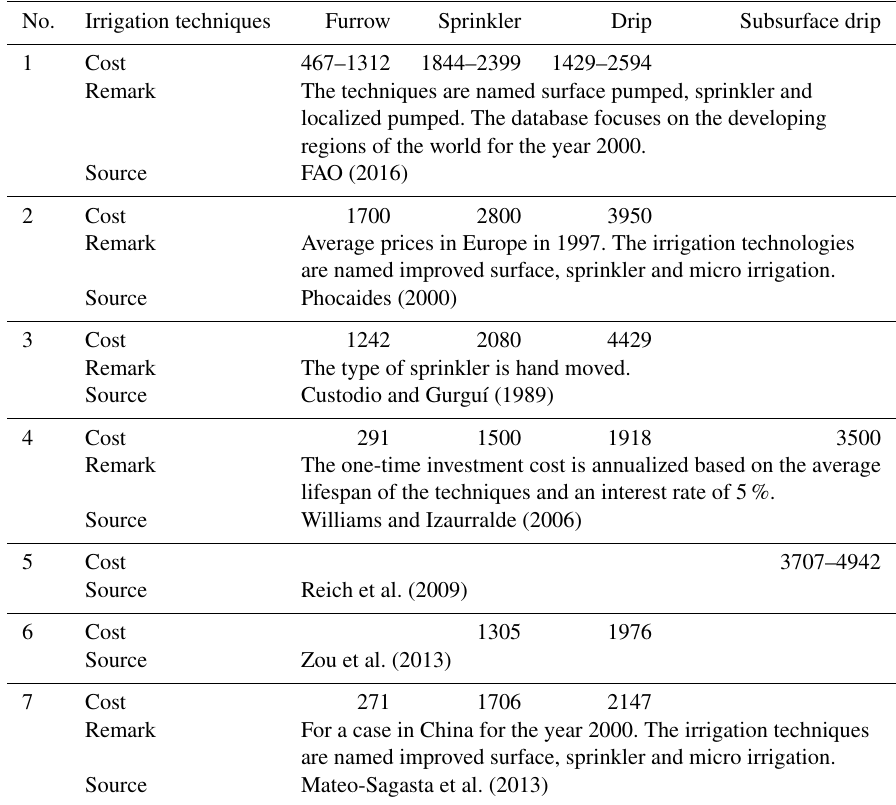
Table A1. Estimates of the investment cost of irrigation techniques (USDha − 1 yr − 1 ) .